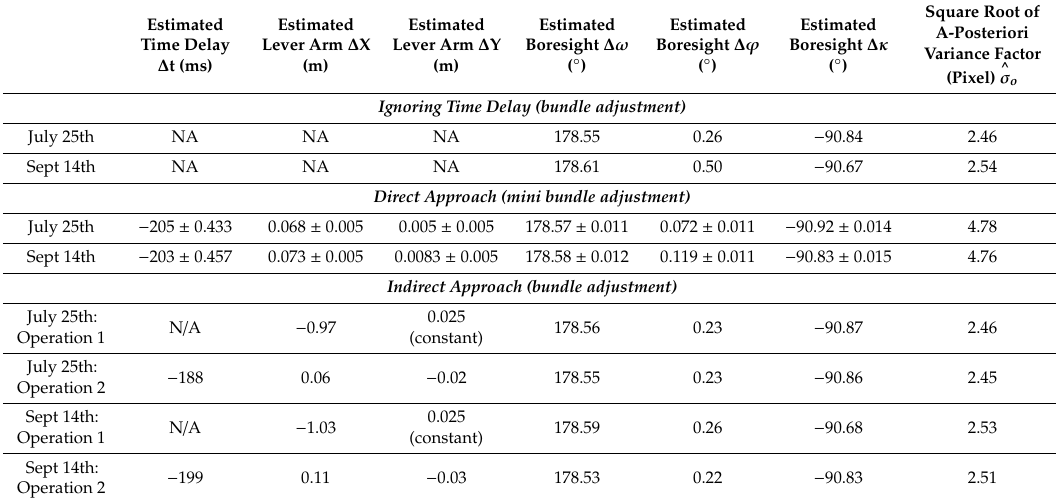
Table 10. Estimated parameter results for the DJI M200 RGB platform including the standard deviation for direct